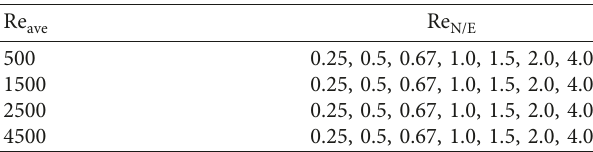
Table 2: Summary of the experimental cases at cross junctions with � 1. and Re different Re N/E W/S